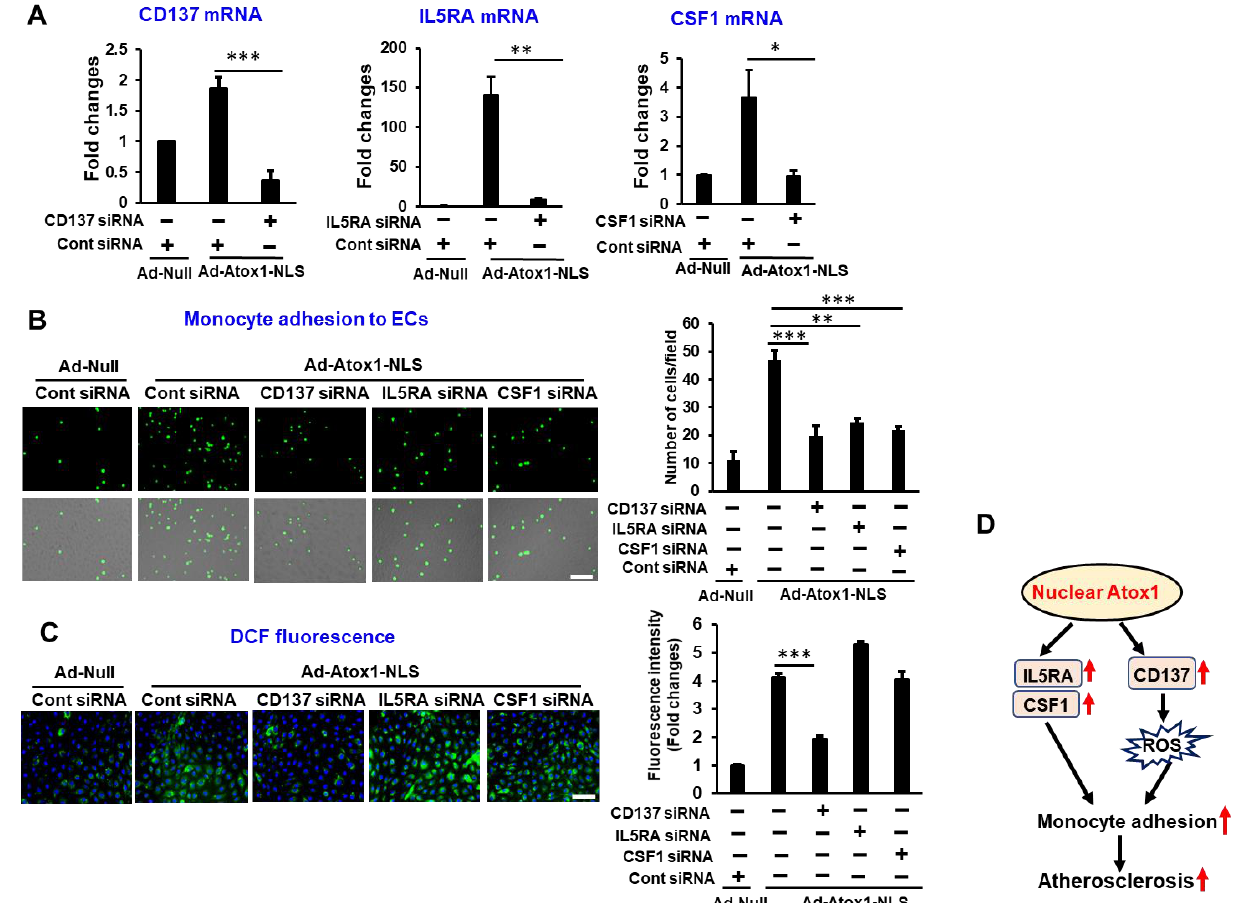
Figure 7. CD137, IL15RA, and CSF1 as new Atox1 targets to regulate inflammation and ROS production in ECs. ECs were transfected with CD137 or IL5RA or CSF1 siRNA. After 16 h, cells were transfected with Ad-Atox1-NLS or Ad-null for 48 h. ( A ). Cells were harvested and CD137 or IL5RA or CSF1 mRNA expression measured. Panel shows averaged data, expressed as fold change over Ad-Null (the ratio in Ad-Null-treated ECs transfected with Control siRNA was set to 1). ( B ). The numbers of bound THP1 monocytes (fluorescently labeled) to ECs were measured with a fluorescence microscope. Right panel quantification (n = 3). Scale: 100 μ m. ( C ). Representative images for DCF fluorescence and DAPI staining (blue, nucleus marker) and quantification of fluorescence intensity (right) (n = 3). Scale: 100 μ m. *** p < 0.001, ** p < 0.01, * p < 0.05. ( D ). Schematic diagram illustrating the mechanisms underlying the effect of Atox1-mediated inflammation and atherosclerosis.